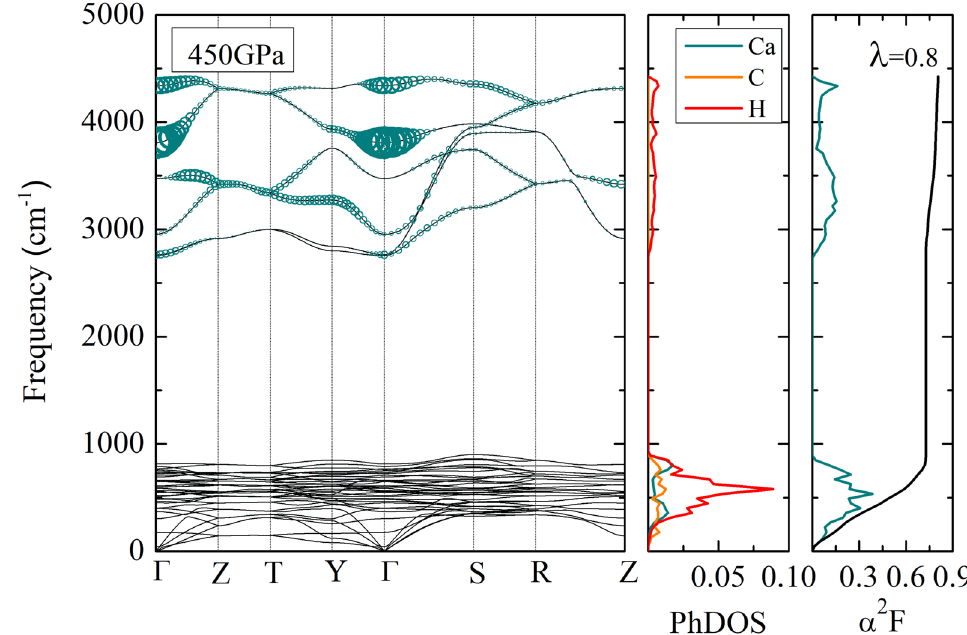
Figure 7. The phonon dispersion of the Cmcm structure, phonon density of states, the Eliashberg spectral function of the Cmcm , and the integration of the lambda of the Cmcm at 450 GPa. Magnitude of partial EPC parameter represents by the circle on the phonon dispersion